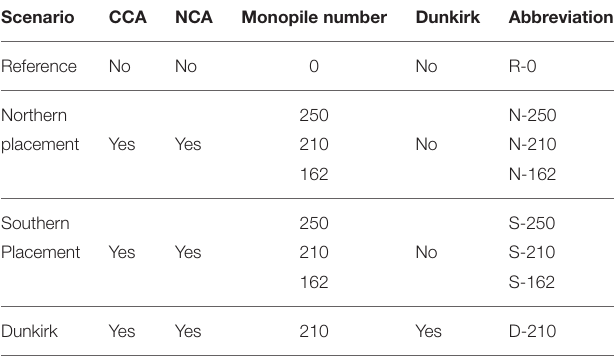
TABLE 3 | List of scenarios that are selected for running the